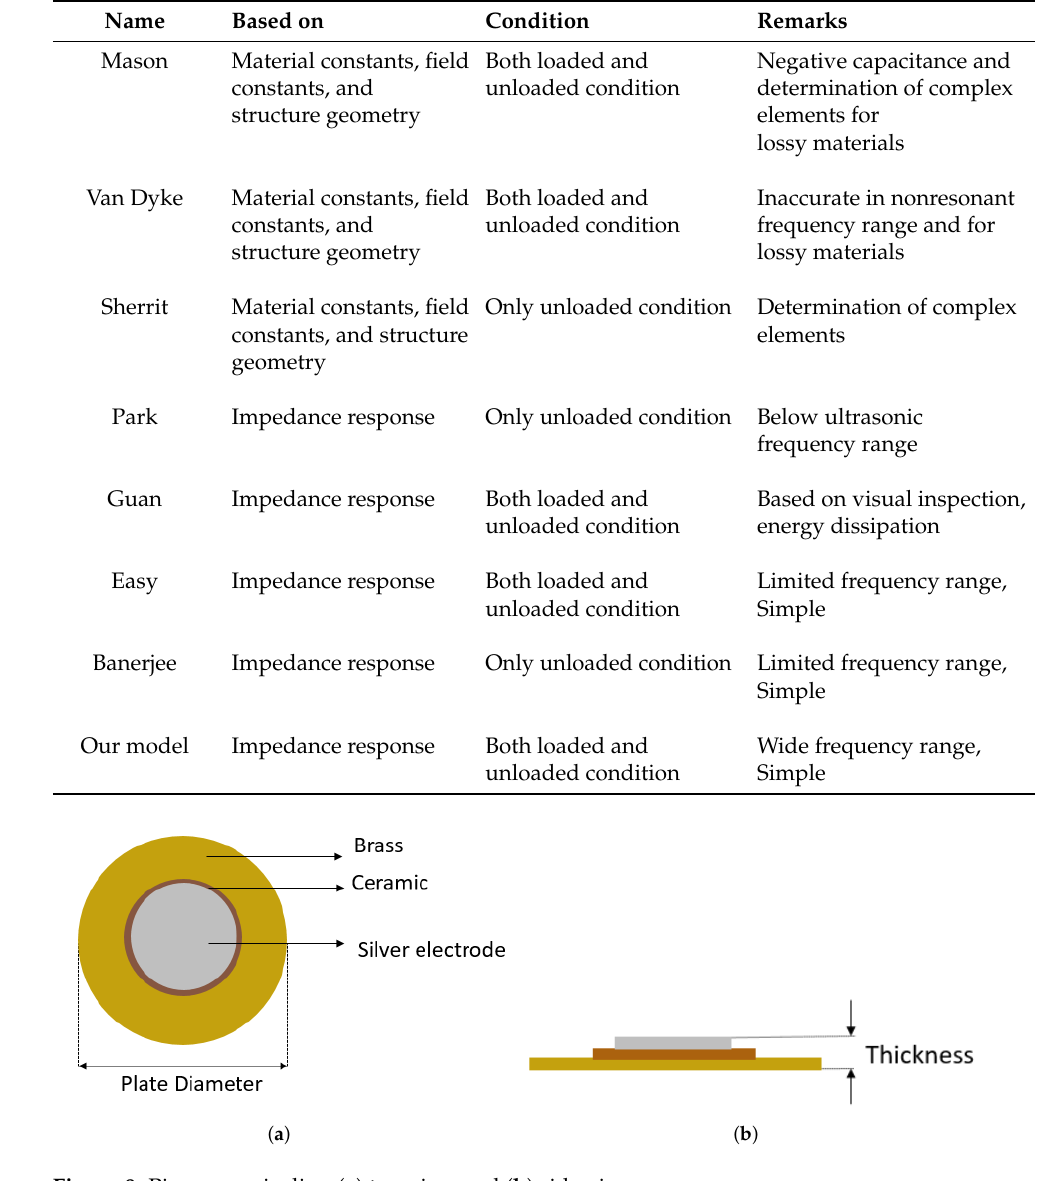
Figure 8. Piezoceramic disc: ( a ) top view and ( b ) side view. Table 2. Physical parameters of 3 perovskite lead zirconate titanate (PZT)